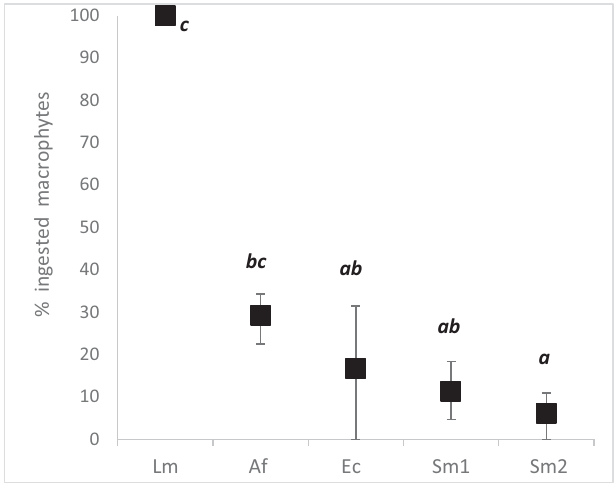
Fig. 2. Palatability of fi ve fl oating macrophytes for the giant gourami ( Osphronemus goramy ) in % ingested macrophytes over a period of 4h. Data are shown as the median and 25% and 75% quartiles. Lm: Lemna minor ; Af: Azolla fi liculoides ; Sm1: Salvinia molesta type1; Sm2: Salvinia molesta type 2; Ec: Echhornia crassipes. Treatments with the same letter are not signi fi cantly different (Kruskal – Wallis ANOVA).